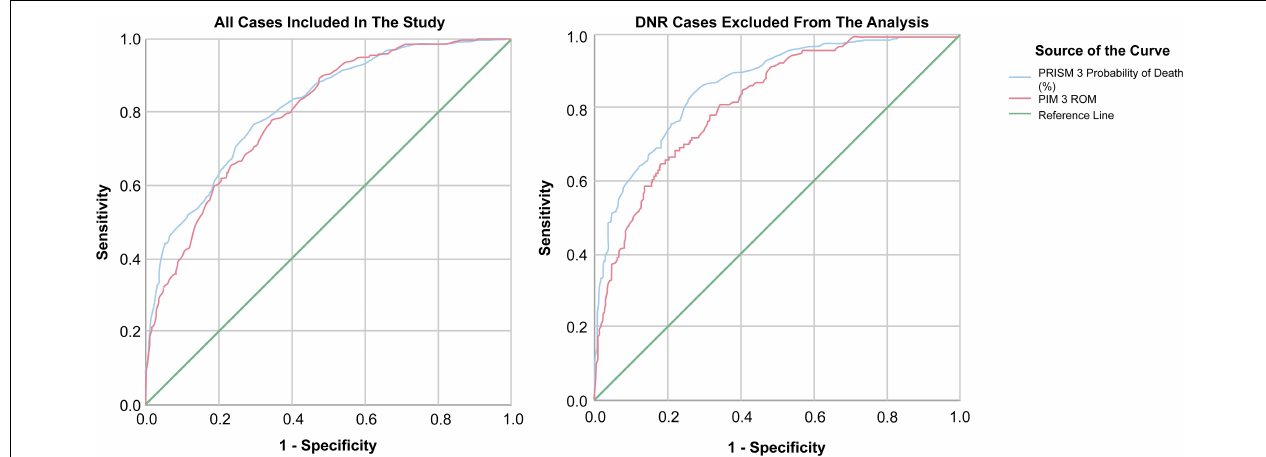
FIGURE 3 | Mortality indices